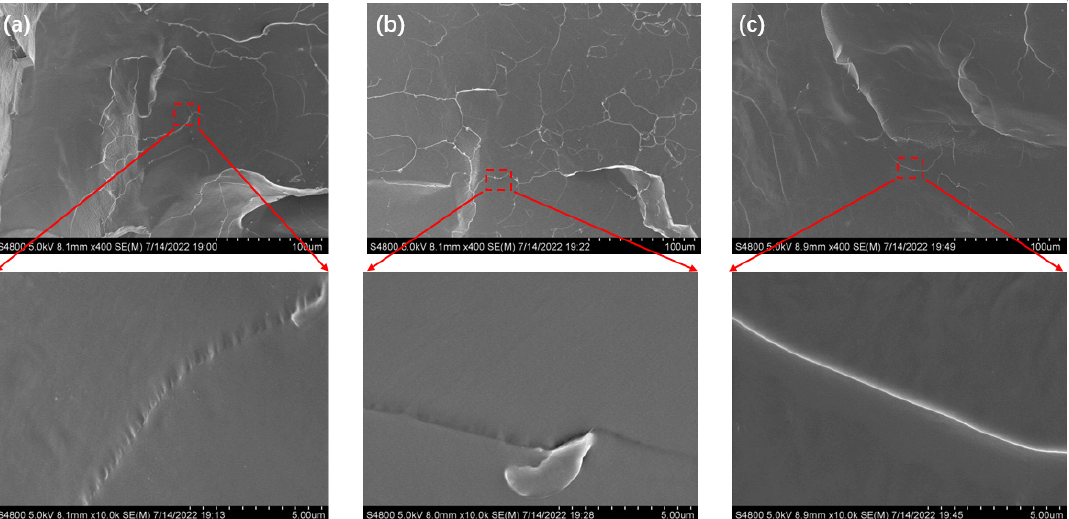
Figure 6. SEM images of the MPU/AO ‐ 80 composites: ( a ) 3MCPG ‐ 0, ( b ) 3MCPG ‐ 16, and ( c ) 3MCPG ‐ 32 (the lower panel is the magnification of the red ‐ box part in the upper panel).